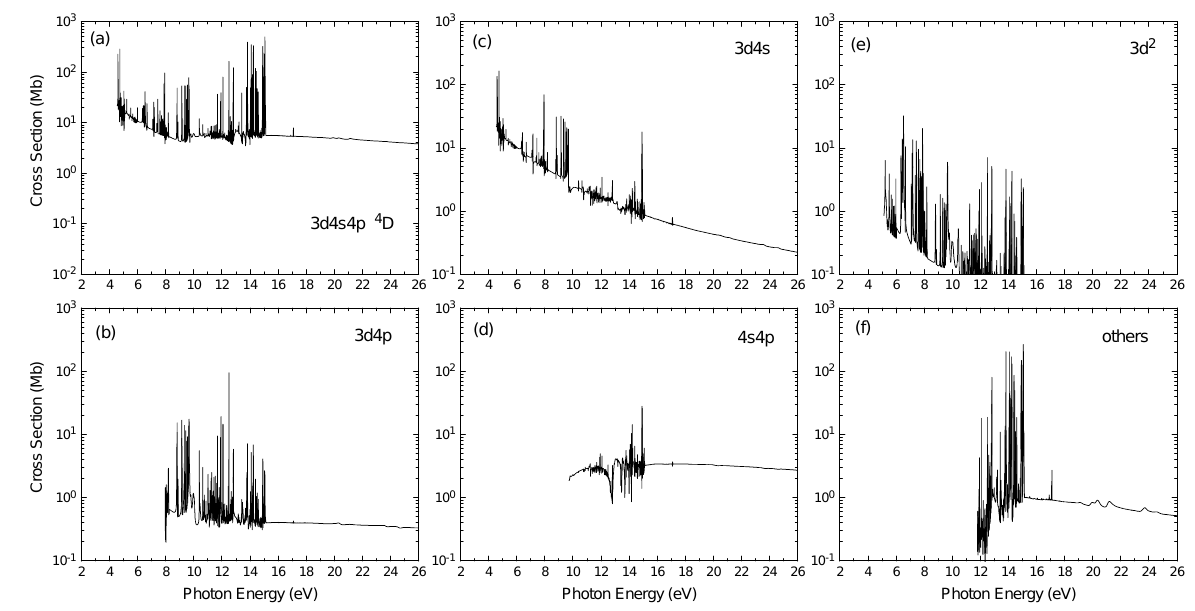
Figure 3. Cross sections for photoionization from the excited 3 d 4 s 4 p 4 D state of Sc. ( a ) shows total cross-sections from the present BSR-81 model whereas ( b – f ) show summed partial cross-sections for leaving the residual Sc + ion in final states of the 3 d 4 p , 3 d 4 s , 4 s 4 p , and 3 d 2 configurations, respectively, along with contribution of all other